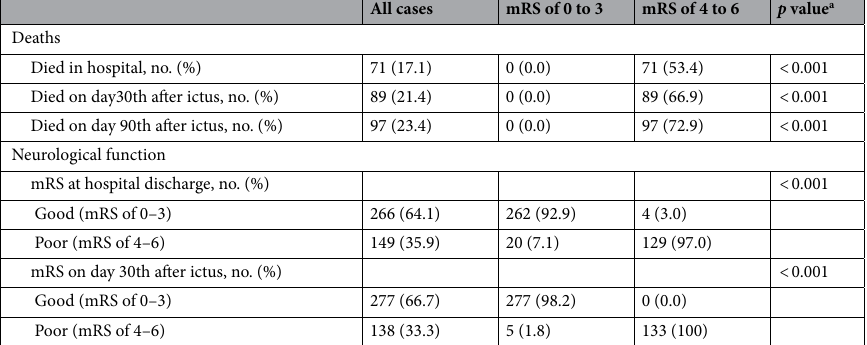
sion analyses, we found that most grades of the SAH grading scales (i.e., PAASH, WFNS, and H&H scales) were significantly associated with the increased risk of poor outcome on days 30th and 90th after ictus, with grade I taken as a reference, except for associations between grade II of the H&H scale and the poor outcome on day 30th (OR: 0.727; 95% CI 0.247–2.139; p = 0.563) and day 90th (OR: 0.727; 95% CI 0.247–2.139; p = 0.563) after ictus (Table 4).